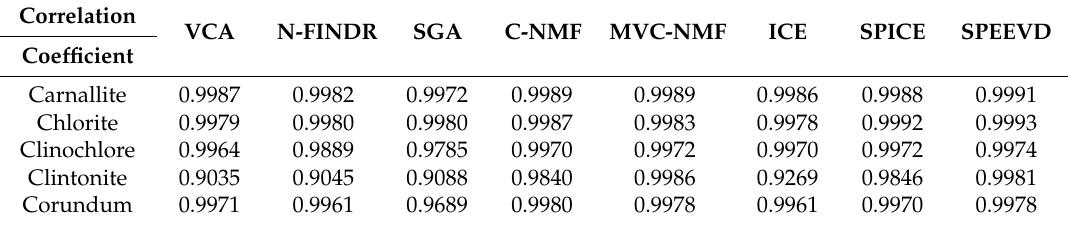
Table 1. The correlation coefficients between the extracted endmembers and the USGS library spectra.